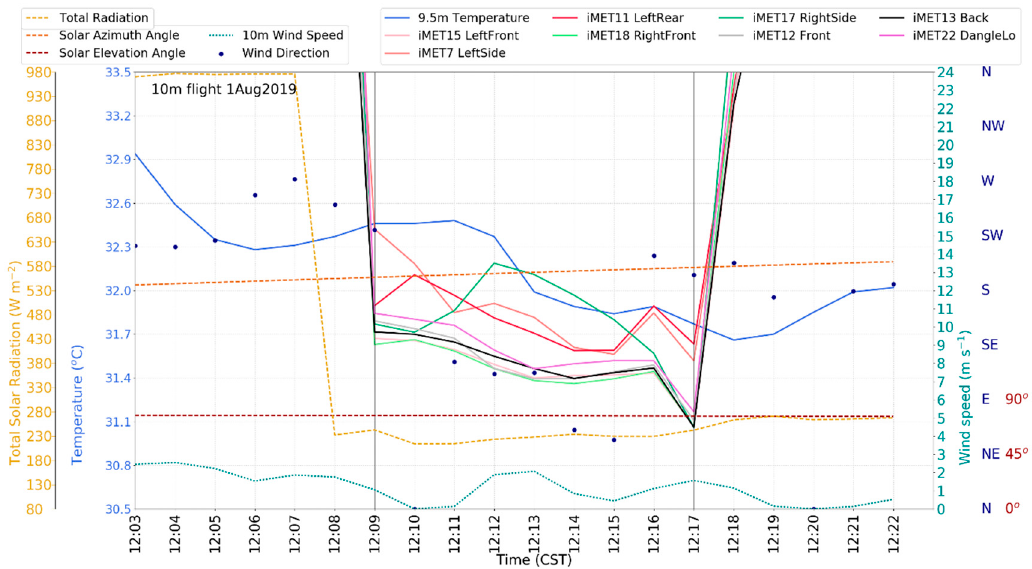
Figure 14. Time series from the 1 August 2019 of the tower temperature at 9.5 m (°C, solid blue), iMET-XQ temperatures (°C, various solid colors as shown in the legend), solar radiation (W m − 2 , dashed mustard yellow), solar azimuth angle (degrees, dashed orange), solar elevation angle (degrees, dashed brown), tower wind speed at 10 m (m s − 1 , dotted green), and the tower wind direction at 10 m (degrees, dark blue dots). The two vertical black lines indicate the start and end times of the 10 m flight.